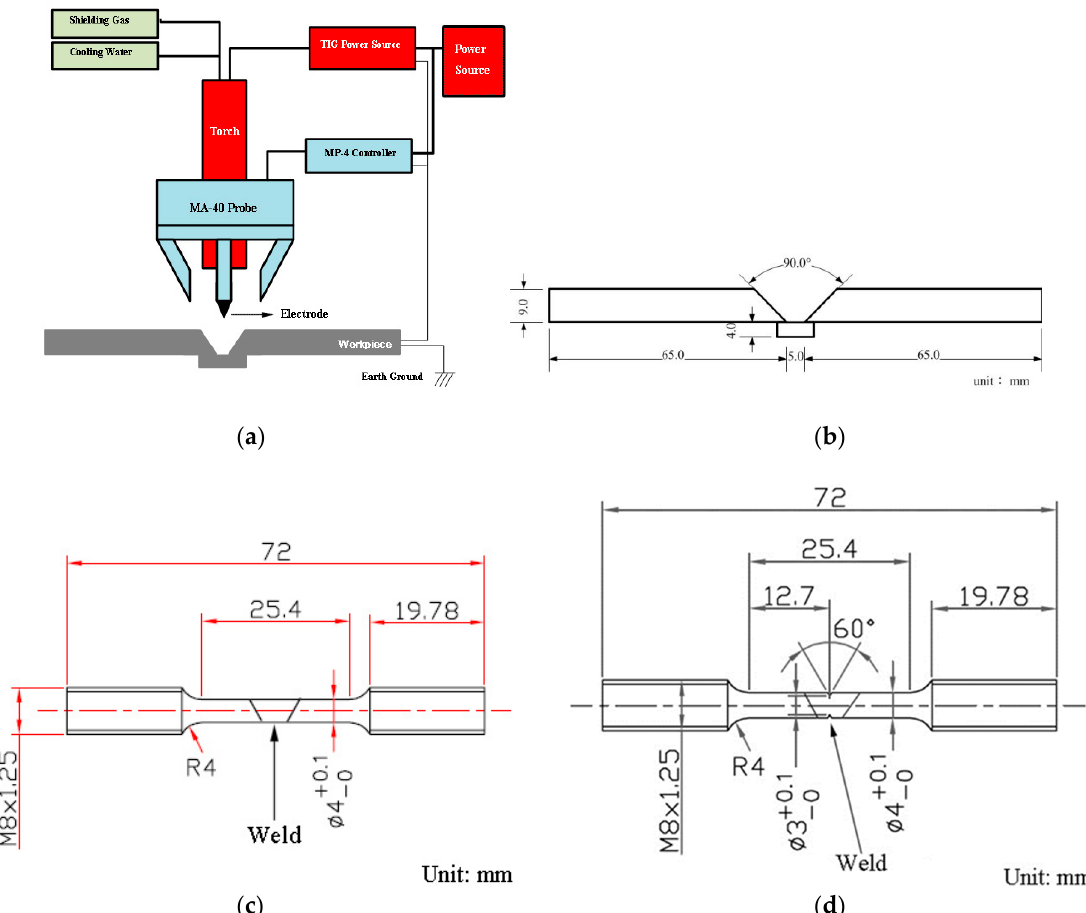
Figure 1. ( a ) Schematic diagram of the experimental set-up for the external electromagnetic stirring equipment, ( b ) welding configuration, ( c ) dimensions of the standard tensile specimen, ( d ) dimensions of the notched tensile specimen.